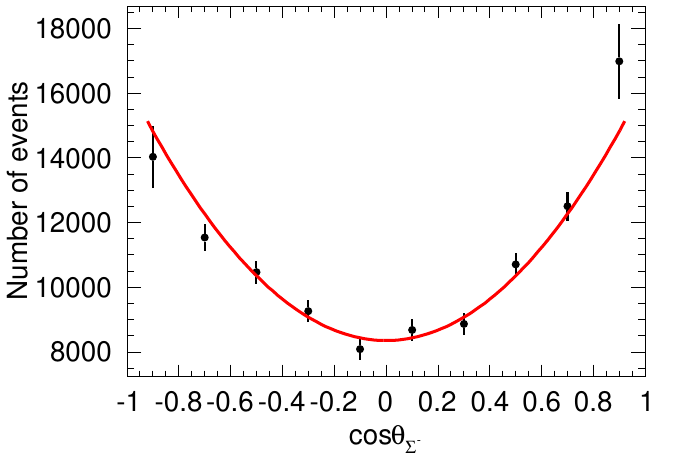
Figure 2 . The angular distribution for the signal process ψ (3686) → Σ − ¯Σ + , Σ − → nπ − , ¯Σ + → ¯ nπ + . The black dots with error bars indicate the signal yields after efficiency correction, and the red curve represents the fit